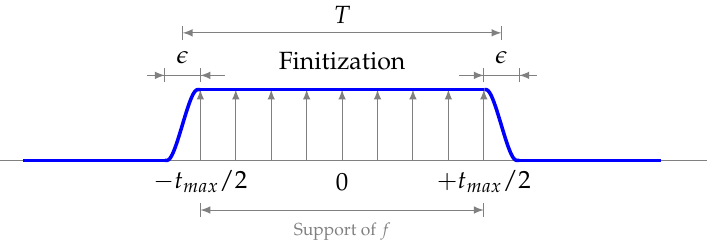
Figure A1. Finitization of a tempered distribution.